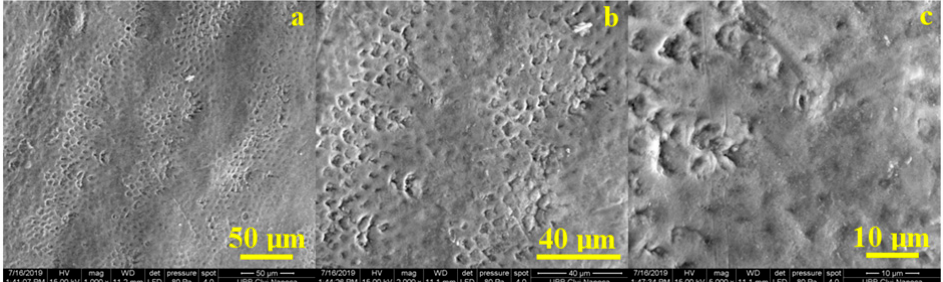
Figure 7. SEM aspect of untreated healthy enamel: ( a ) small magnification, ( b ) medium magnification, and ( c ) high magnification.